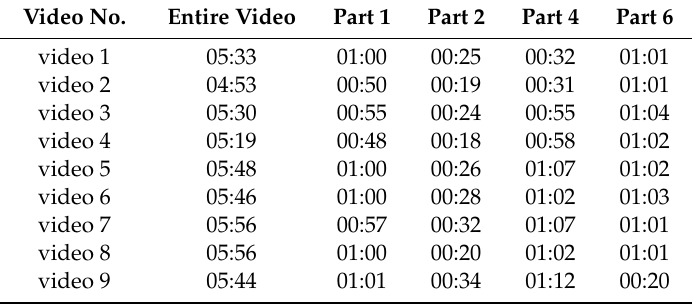
Table A1. Duration of the recorded video sequences and selected parts (mm: